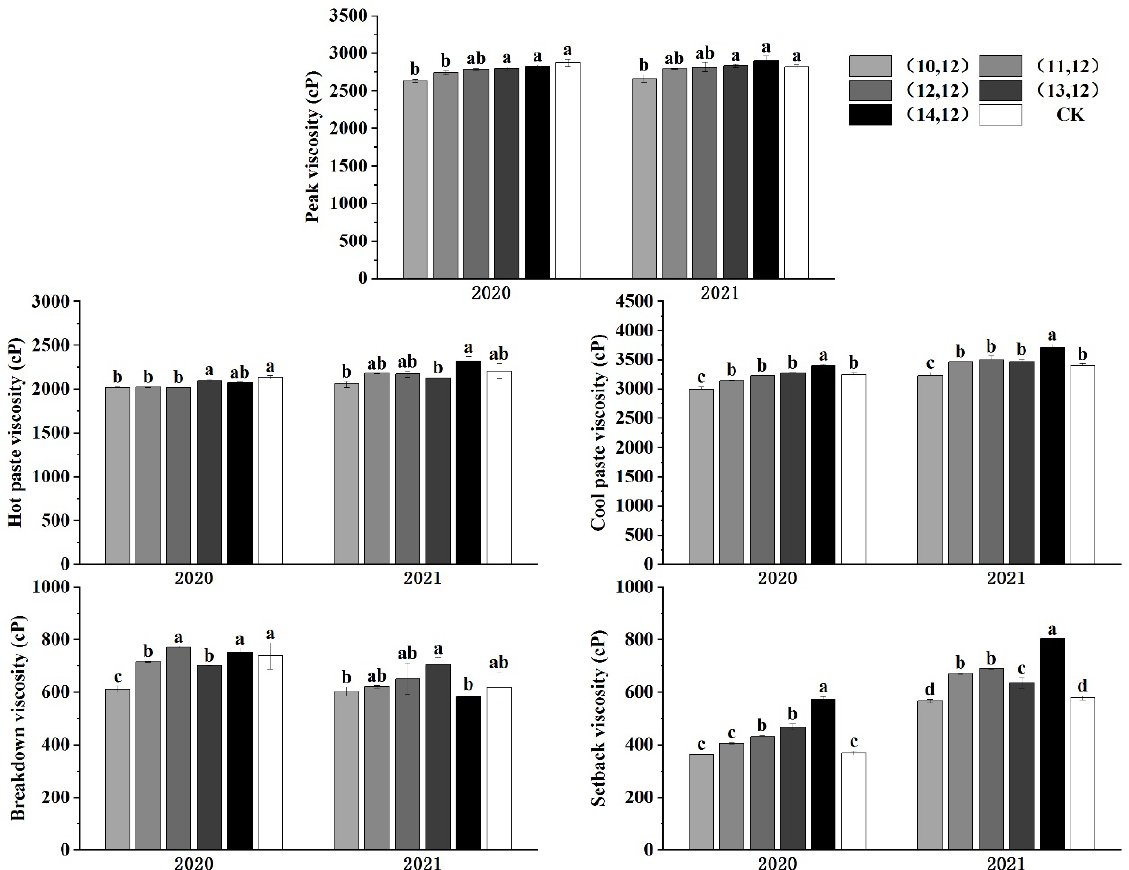
Figure 5. Effects of N and K application on RVA profile characteristics under different leaf age patterns in 2020 and 2021, with the results of the two-factor ANOVA. The (10, 12), etc., represent the patterns of different applications of N and K at the panicle stage; CK is the fertilization pattern of local farmers. Error bars indicate standard errors of three replicates. Different lowercase letters above the columns indicate significant differences ( p < 0.05) among different panicle fertilizer application patterns in the same year. Table 5. Effects of different N and K combined application rates during the panicle stage on RVA profile characteristics in 2020 and 2021, with the results of the three- way ANOVA.